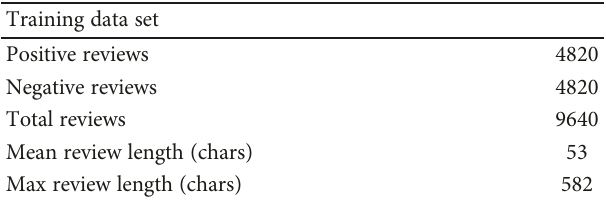
Table 2: Training data set.